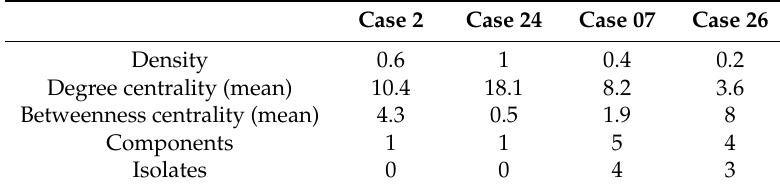
Table 6. Structural measures of personal